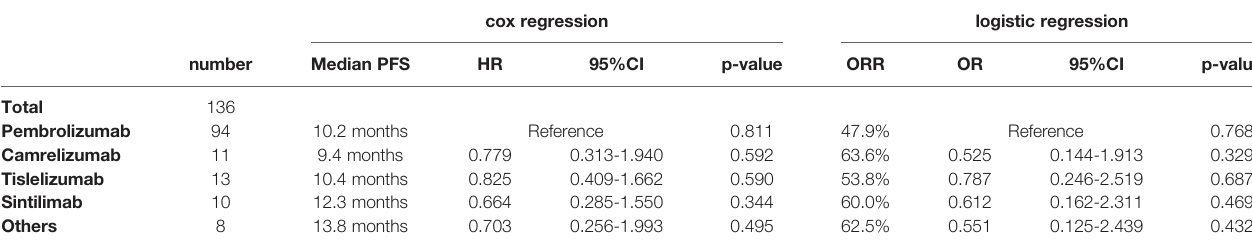
TABLE 3 | Differences in ef fi cacy between ICIs (Stage IV, fi rst line, ECOG 0-1 patients). cox regression logistic regression